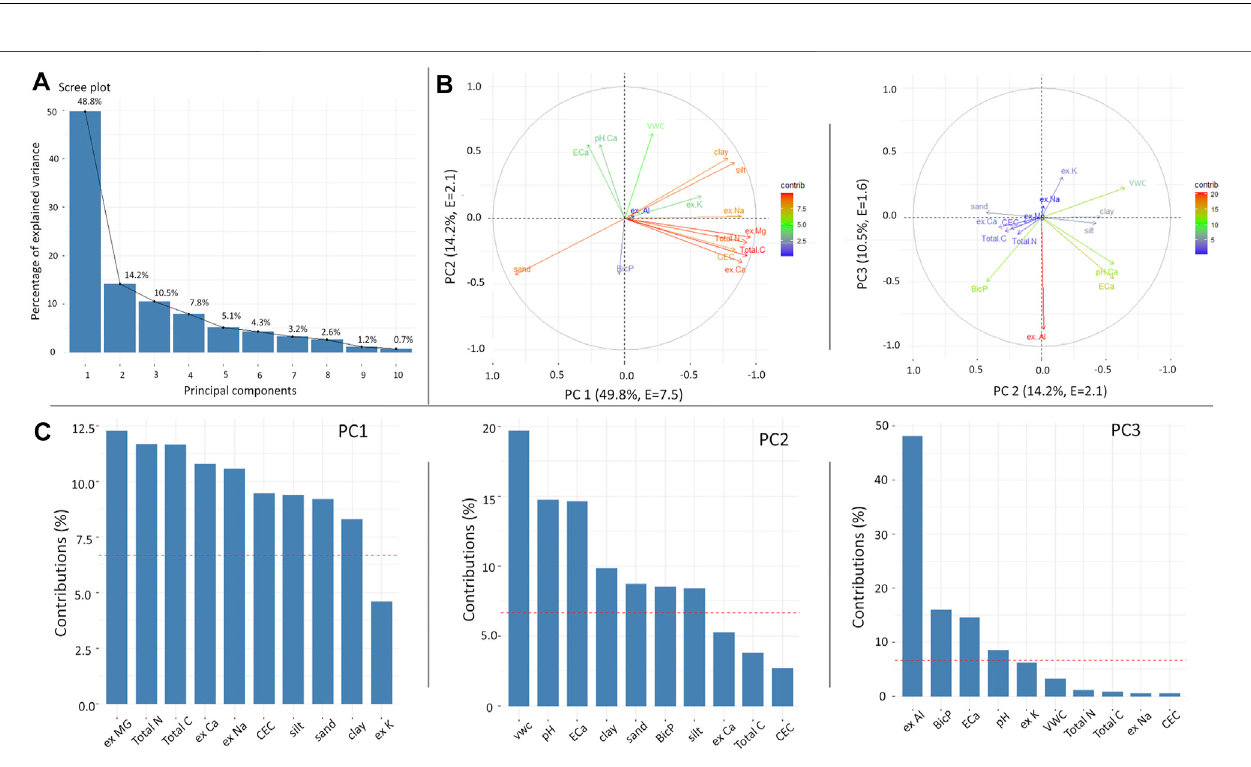
FIGURE 9 | Principal component analysis for Mooribin soil parameters showing (A) scree plot, (B) variables highlighted based on their percent contribution in correlation plots, and (C) contribution of variables in selected PCs, where the red line shows the expected average contribution (cut-off). The soil variables included are sand, silt, clay, volumetric water content, pH, CEC, Total N &Total C, ex Mg, ex Na, ex Ca, ex Al, ex K, BicP, and inverted EC from 10 m around each sample.